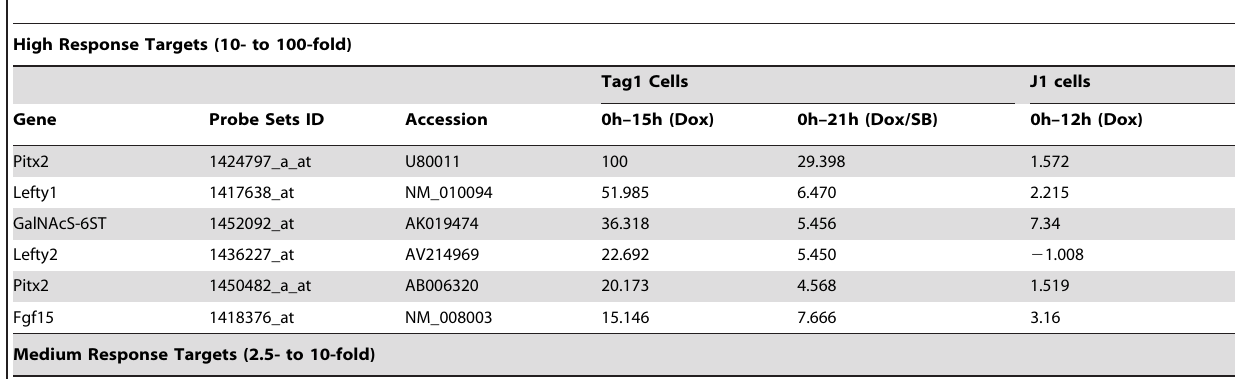
Table 1. Behaviour and classification of gene expression in the Dox/SB15 experiment.